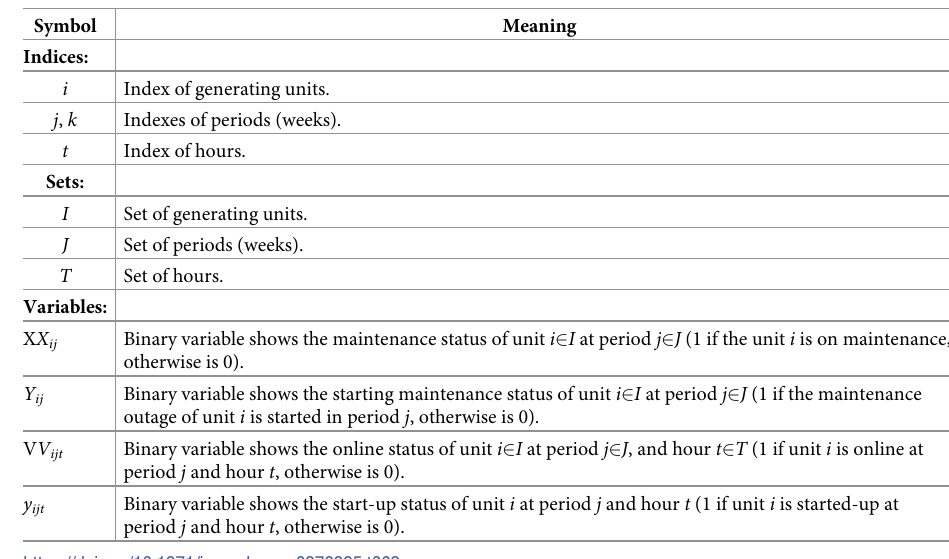
Table 2. Decision variables for generator maintenance